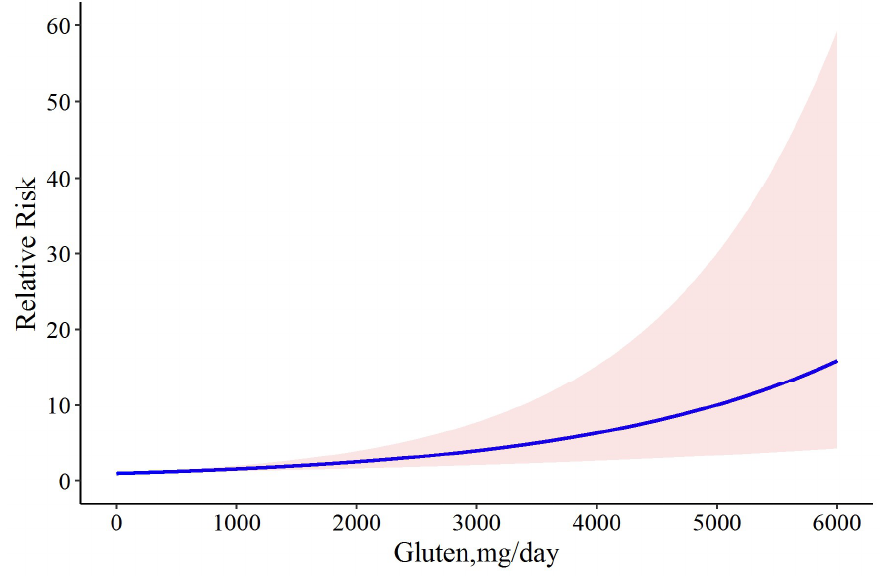
Figure 3. The dose-response meta-analysis of gluten dose and risk of CD relapse. The solid curve and the shadow area indicate the relative risk with a corresponding 95% confidence interval.